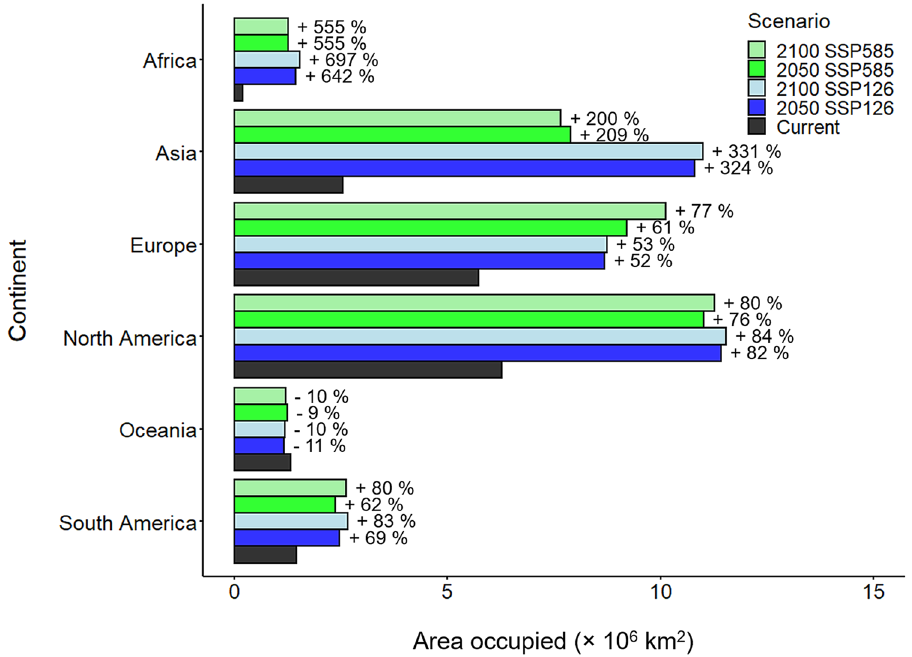
Figure 5. Estimated occupied areas (km 2 ) by Craspedacusta sowerbii according to the current and future (2050 and 2100)